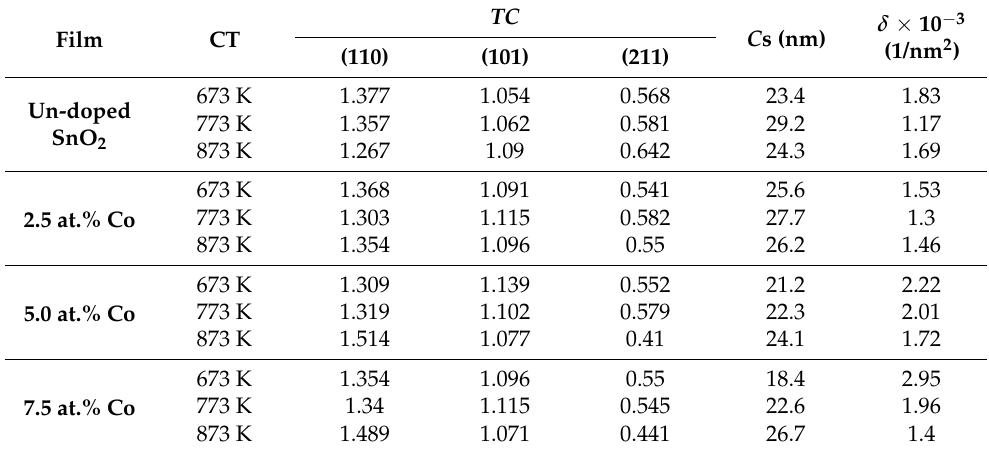
Table 1. XRD data: calcination temperature CT, the texture coefficient ( TC ) for (110), (101), and (211) planes, crystallite size Cs and dislocation density δ